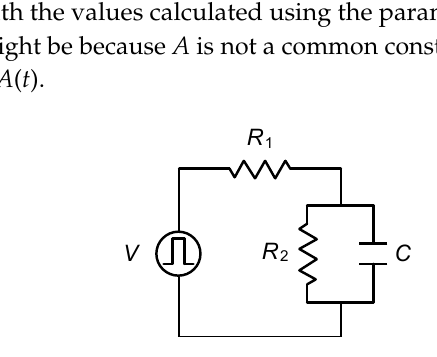
Figure 4. Equivalent circuit based on a model in which the OLED acts as a capacitor during the reverse bias. Here, V is the absolute value of the applied voltage, R 1 is the internal resistance, R 2 is the resistance of the OLED, and C is capacitance.